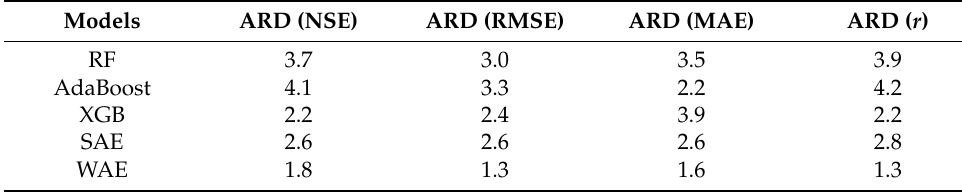
Table 5. The ARD of each model in each fold for NSE, RMSE, MAE, and r . Models